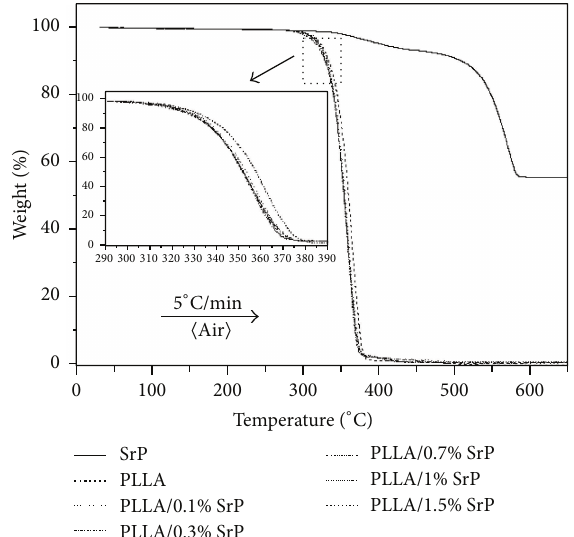
compared with other PLLA/SrP samples, indicating that excess SrP is a powerful inhibitor for PLLA crystallization.